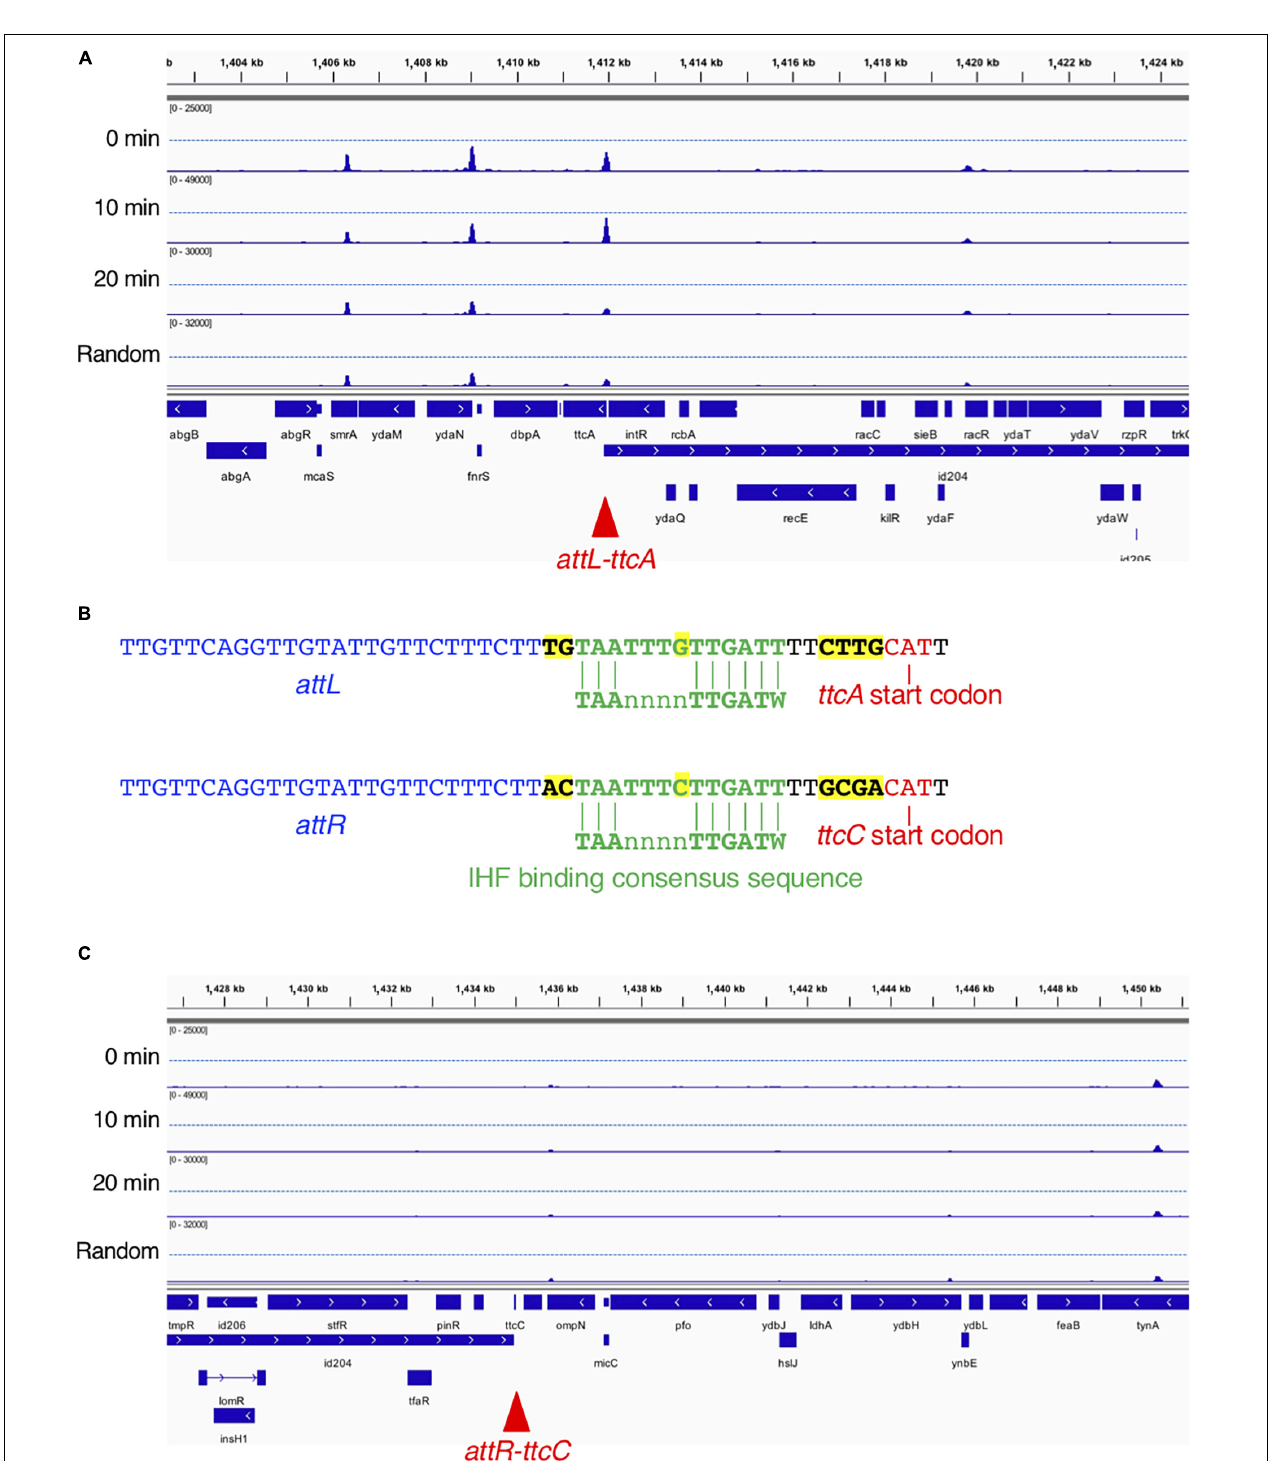
FIGURE 7 | Time-resolved IHF binding at the ttcA -Rac prophage locus. (A) IHF-binding profiles at the ttcA upstream region in the 0 min, 10 min, 20 min, and Random samples. Red arrowhead represents the locus with IHF binding at specific timing (10 min) after replication initiation, which corresponds to Rac prophage attachment site attL . (B) Sequence comparison of Rac prophage attachment sites and IHF-binding consensus sequences in ttcA (top) or ttcC genes (bottom), and characters with yellow highlight is sequences different in ttcA or ttcC genes. The start codons of the ttcA or ttcC genes are shown by red characters. IHF-binding consensus (TAAnnnnTTGATW, where W means T or A) is shown by green characters. Rac prophage attachment sites attL or attR are shown by blue characters. (C) IHF-binding profiles at the ttcC upstream region in the 0 min, 10 min, 20 min, and Random samples. Red arrowhead represents the locus with Rac prophage attachment site attR